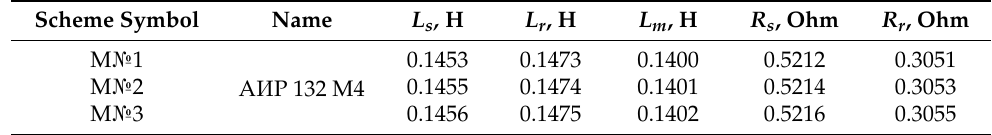
Table 3. Parameters of the motor substitution